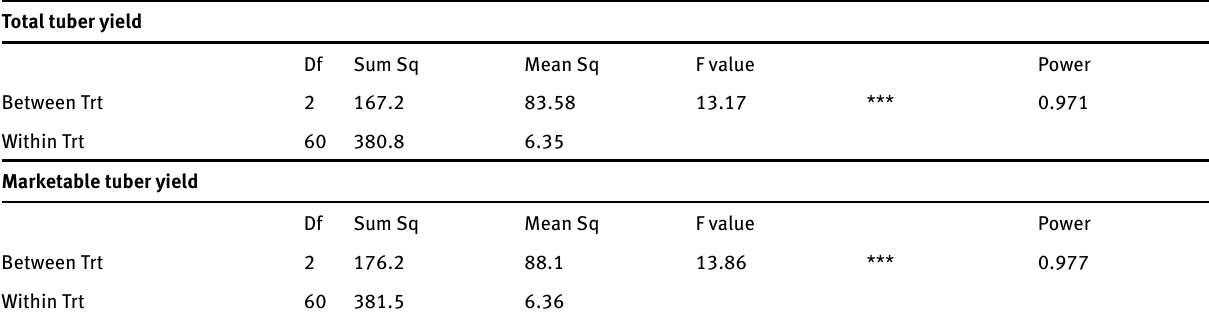
Table 2. ANOVA for the Goodness-of-fit test and balanced one-way analysis of variance power, corresponding to the three populations (treatments-Trt) for total tuber yield and marketable tuber yield (*** P<0.001 ). Df = degree of freedom, Sum Sq = Sum of squares, Mean Sq = Mean of